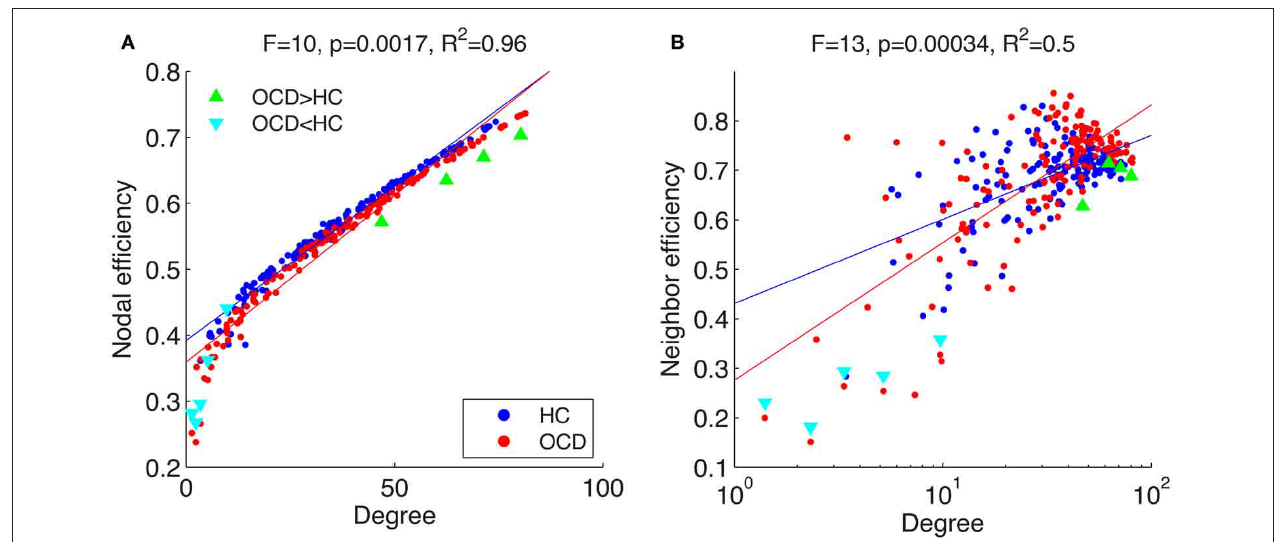
FIGURE 8 | Mean nodal efficiency (A) and neighboring efficiency (B) are shown over mean degrees in a linear (A) and a logarithmic (B) scale. Each point indicate an ROI from the networks of the healthy controls (HC, blue dots) and patients with OCD (OCD, red dots). Specific ROIs with significant group differences in efficiency measures are marked with